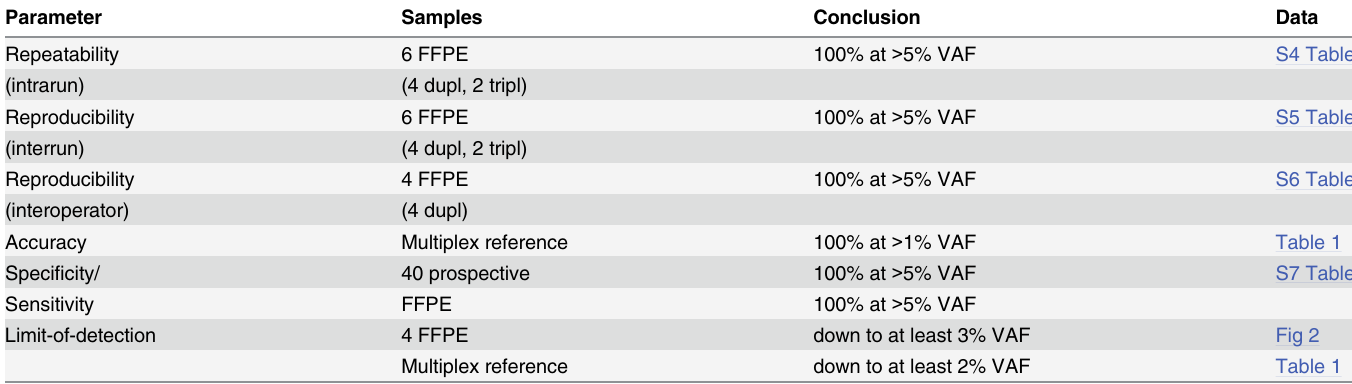
Table 3. Summary of the validation assays and results for the targeted NGS screening on solid tumors (NSCLC, CRC and